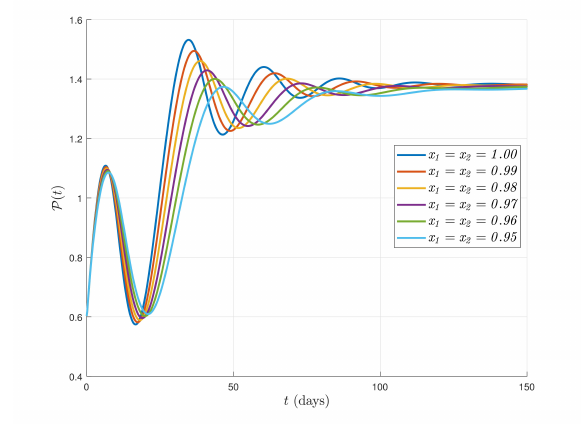
Figure 3. Behaviors of P ( t )